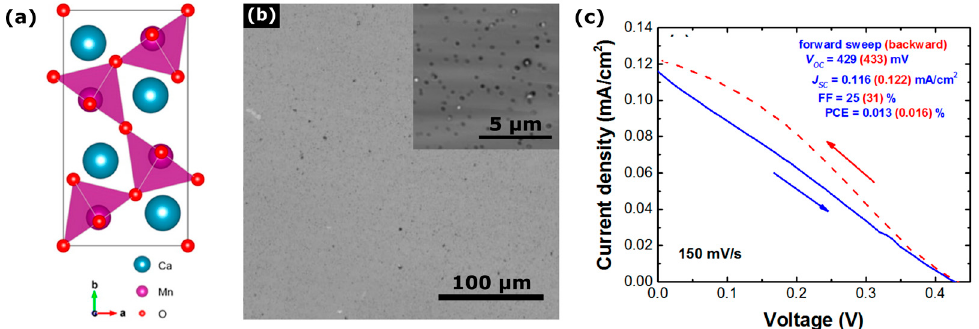
Figure 15. ( a ) Structure of CaMnO 2.5 reproduced from ref. [141], with permission from American Chemical Society, 2014, ( b ) optical microscope images of CaMnO 2.5 after laser fragmentation, the inset shows a high-magnification optical microscope image, and ( c ) current density-voltage characteristic of a CaMnO 2.5 solar cell under solar simulated light.